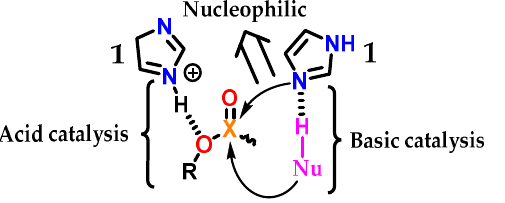
Figure 28. Acidic, basic and nucleophilic catalysis promoted by an imidazole 1 subunit. The amino acid histidine 7 plays a fundamental role in several enzymatic active sites, including ribonucleases, phosphotriesterases, kinases, chymotrypsins and histone deacety- lases [62–65]. As illustrated in Figure 29, histidine 7 residues (H573/H574) participate in the catalytic process of deacetylation of the lysine residue by histone deacetylase 6 (HDAC6). We can also see the residue (H614) acting on the triad of amino acids responsible for sustaining the zinc atom (through the interaction η 1 ( σ ,N py )) present in the catalytic site of the enzyme [7,65].